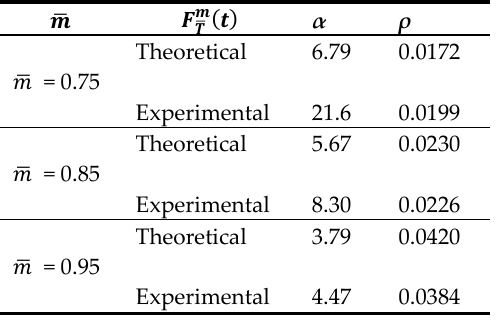
In conclusion, the forecasts for reaching the threshold (cid:1865)(cid:3365) = 0.95 are better captured